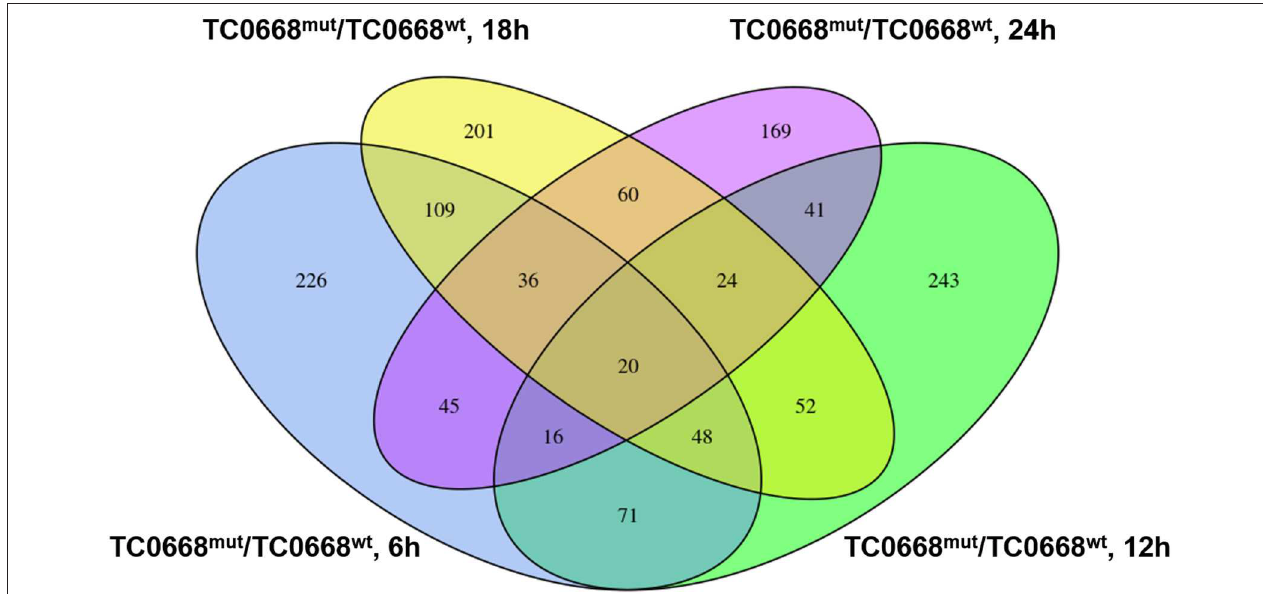
FIGURE 4 | Four-way Venn diagram of the total number of proteins significantly differentially expressed ( P < 0.05) between HeLa cells infected with C. muridarum TC0668 wt or TC0668 mut strains at 6, 12, 18, and 24h p.i. Numbers of shared or unique proteins are indicated at the intersections of the circles in the Venn diagram.